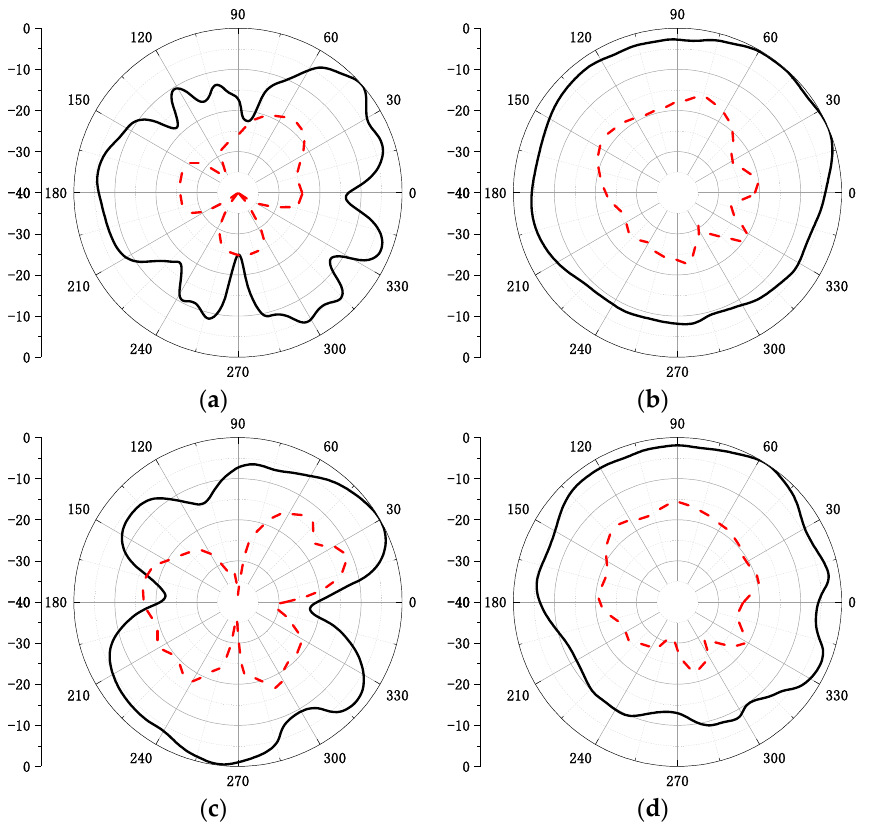
Figure 7. Measured radiation patterns of the proposed antenna ( a ) 2.475 GHz E-plane; ( b ) 2.475 GHz H-plane; ( c ) 3.47 GHz E-plane; and ( d ) 3.47 GHz H-plane.